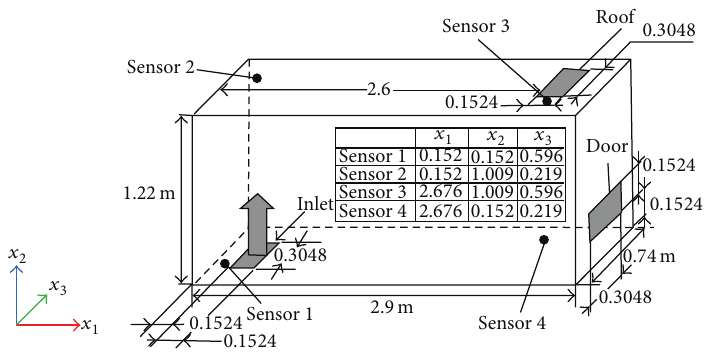
Figure 3: The ventilation model.